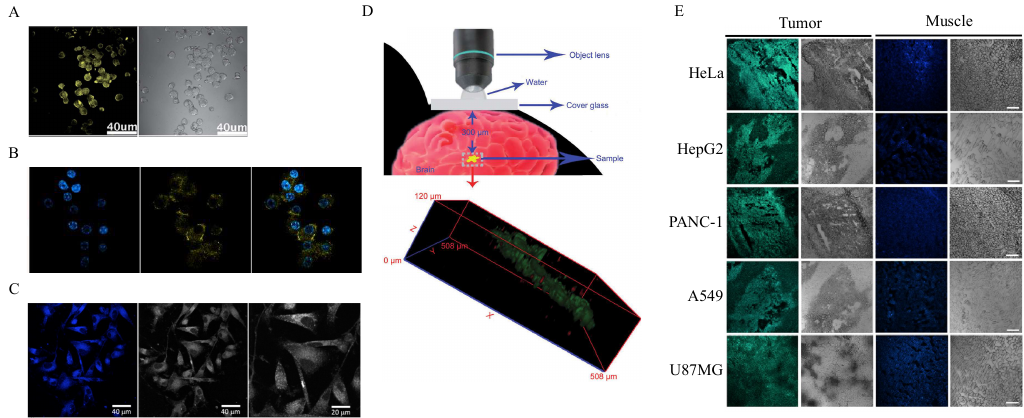
Figure 5. Neuroimaging with GQDs. ( A ) Confocal imaging of neurospheres with GQDs. Adapted with permission from The Royal Society of Chemistry [93]; ( B ) Confocal imaging of human neural stem cells with GQDs (green) and nuclear staining (blue). Adapted with permission from The Royal Society of Chemistry [94]; ( C ) Confocal imaging of U87 cells excited at 407 nm (blue) and 488 nm with N-doped carbon dots. Reprinted with permission [37]. Copyright 2014, American Chemical Society; ( D ) Deep tissue confocal imaging of GO nanoparticles inside mouse brain. Reproduced with permission [95]; ( E ) PH-responsive GQDs injected in mice bearing different tumors and adjacent muscles. Scale bar 40 µm. Adapted with permission from The Royal Society of Chemistry [39]. Table 3. Wavelengths reported in this review for bioimaging, phototherapy and drug delivery on neural cell lineages.